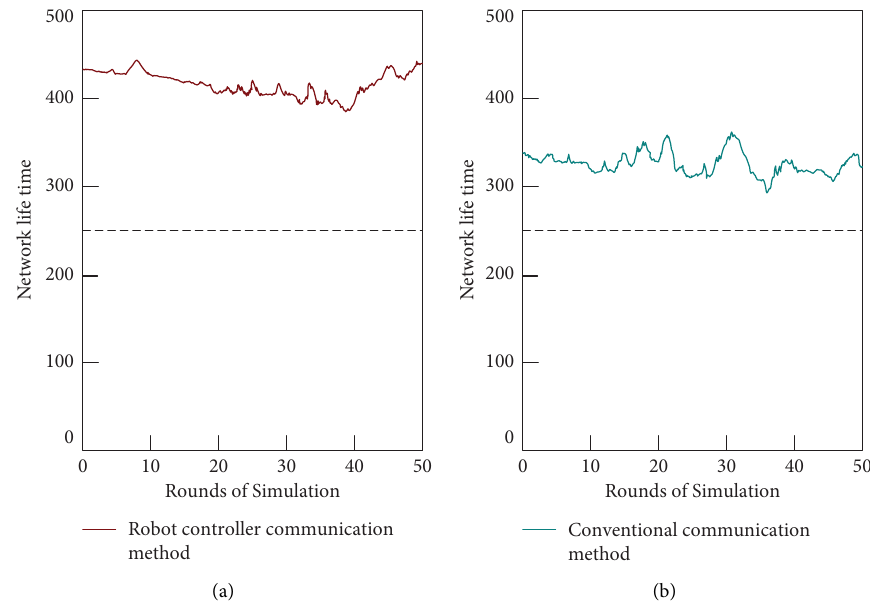
Figure 6: Test results of energy efciency. (a) Te results of the communication method in this paper. (b) Te results of the conventional communication method.